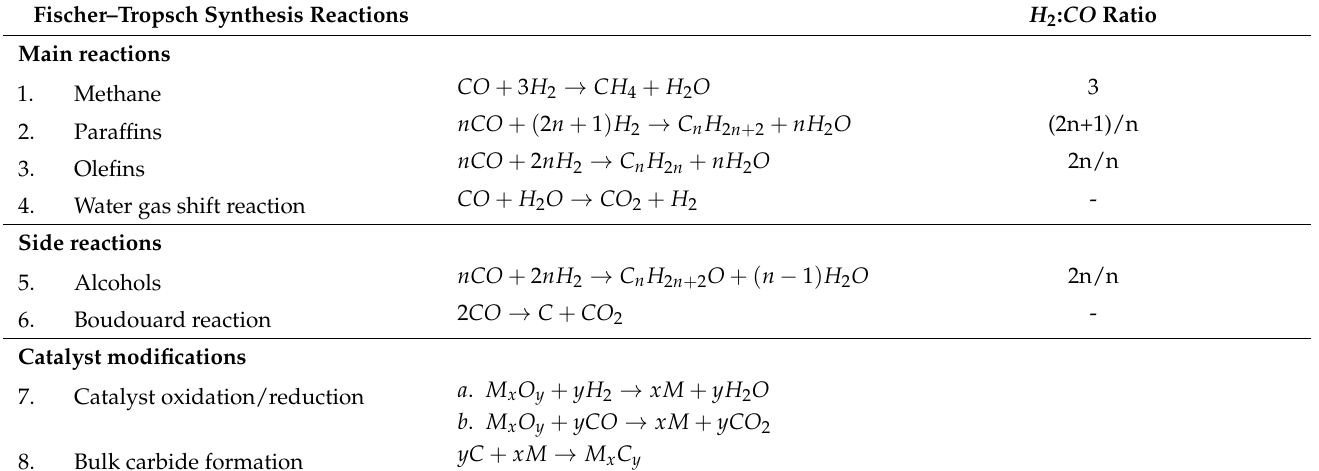
Table 2. Major overall reactions in the Fischer–Tropsch synthesis